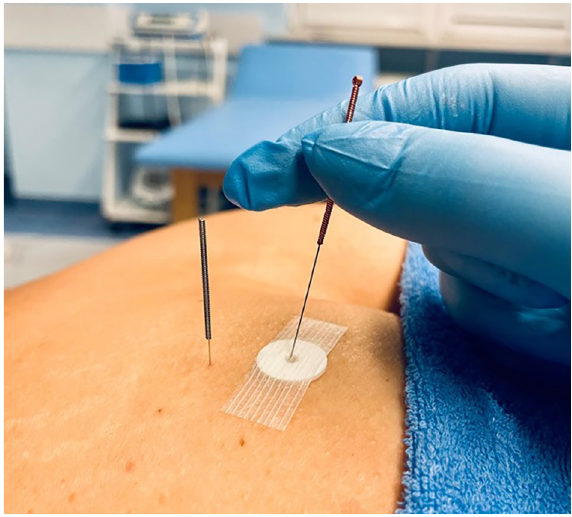
Figure 7. DN application in the control group using telescopic needle (sham therapy). For comparison, an actual needle inserted is presented next to the application